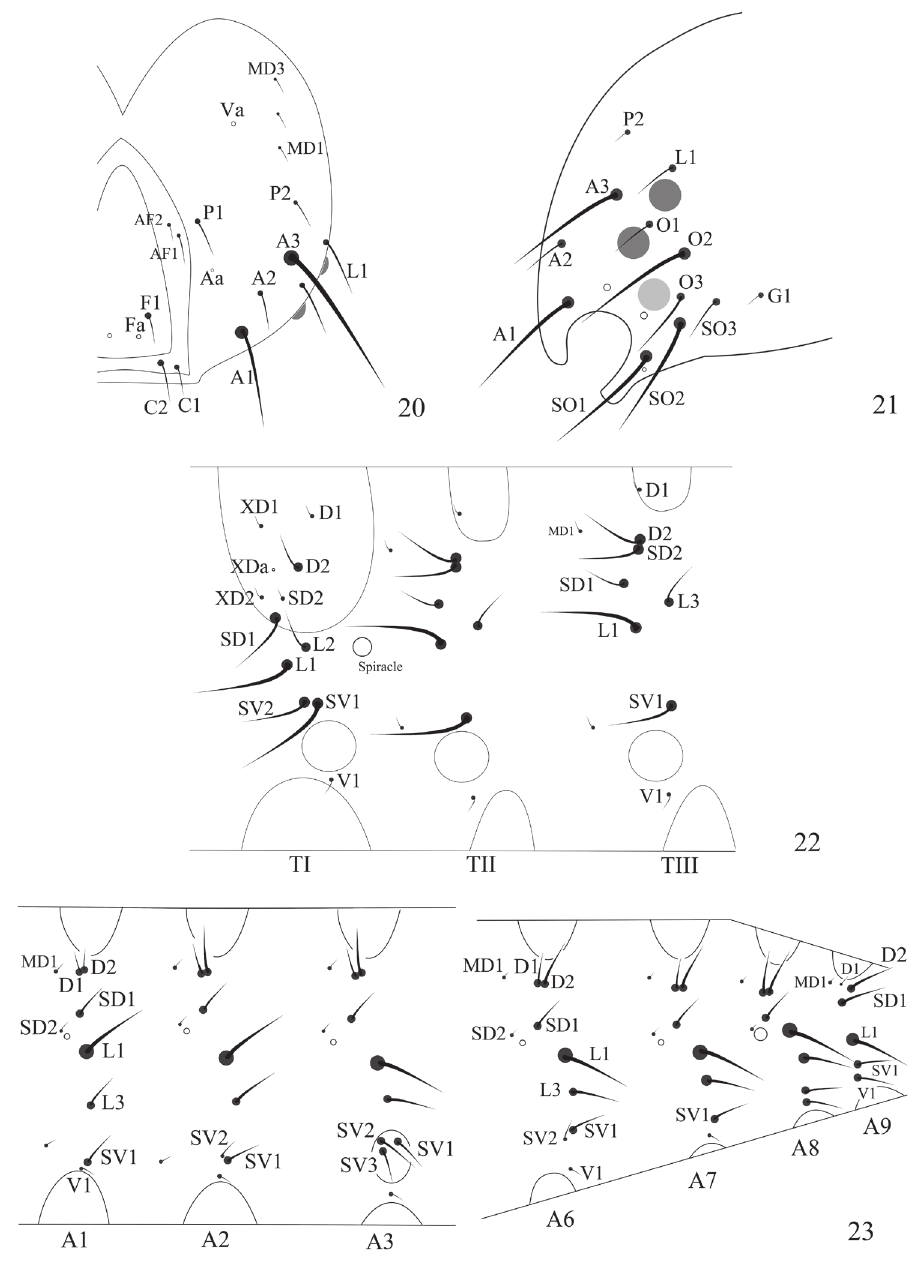
Figures 20−23. Line drawings of the larval chaetotaxy of Telamoptilia grewiae sp. n. 20 Head, frontal view 21 Head, lateral view 22 Thoracic segments, lateral view 23 Abdominal segments, lateral